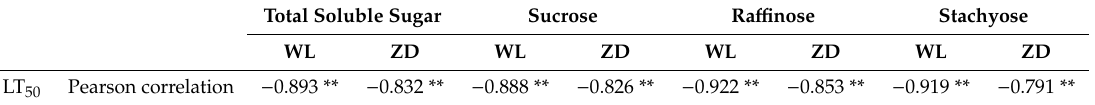
Table 2. Correlation analysis between soluble sugar concentration and semi-lethal temperature (LT 50 ) in alfalfa. Significance di ff erences at the 0.01 level are denoted by double